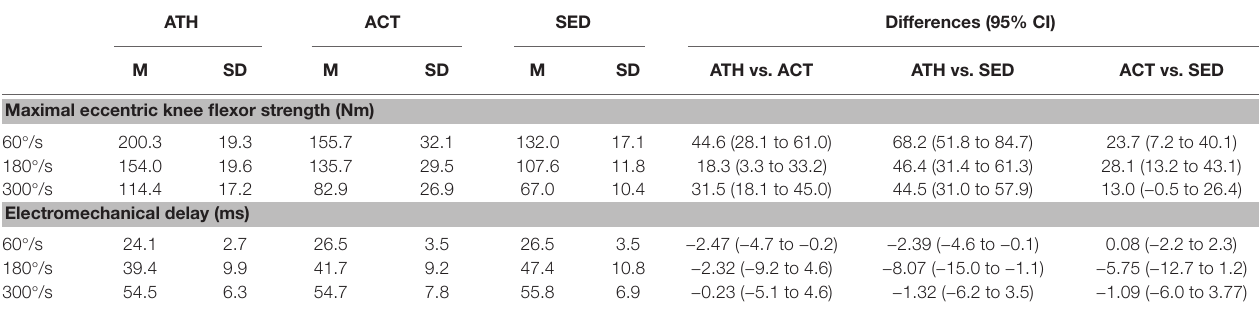
TABLE 2 | Maximal eccentric knee flexor strength and electromechanical delay at baseline and different angular velocities (60, 180, and 300 ° /s) in male athletes (ATH), active (ACT) and sedentary adults (SED). ATH